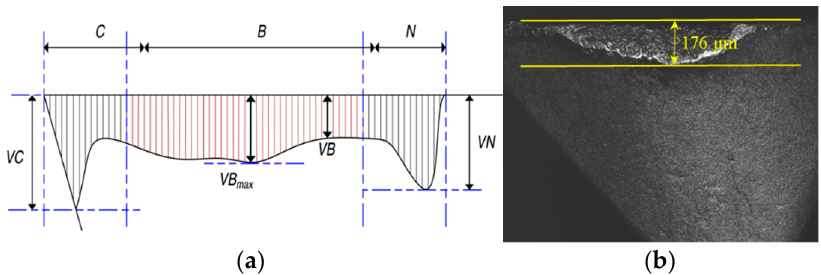
Figure 6. The typical pattern and measurement of flank wear. ( a ) The typical pattern of the flank wear; ( b ) The schematic diagram of flank wear measurement.